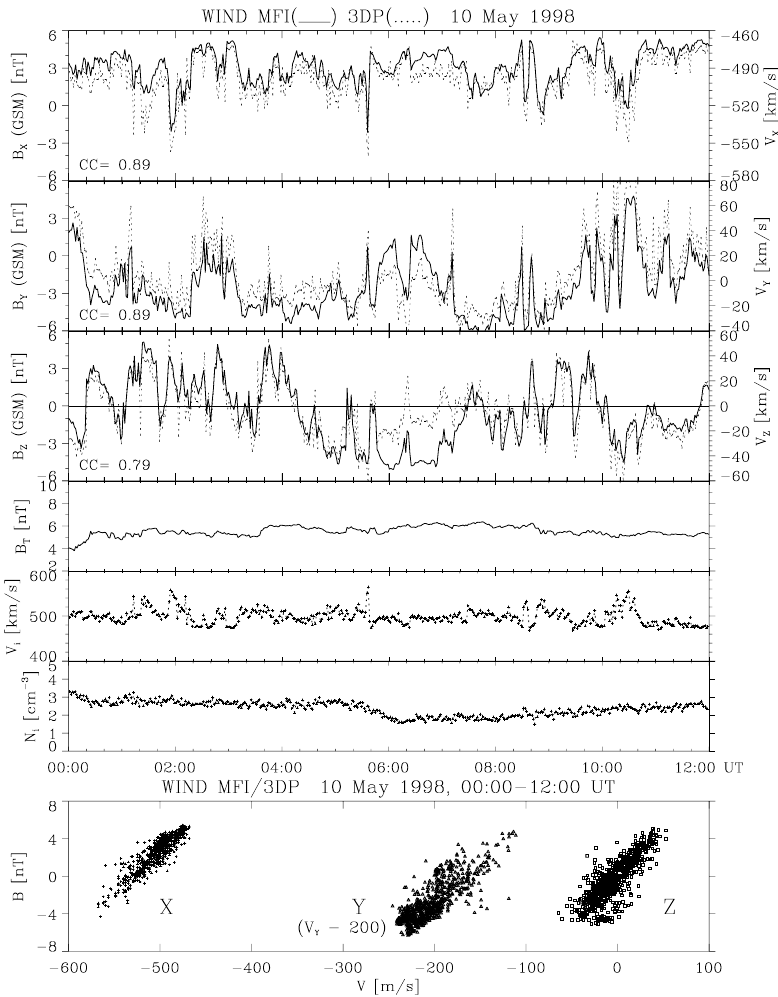
Fig. 2. Alfv´enic fluctuations in the solar wind observed by WIND spacecraft on 10 May 1998. The coefficients of correlation (CC) between the corresponding components of the IMF (solid line) and ion velocity (dotted line) and scatter plots (bottom) are shown.